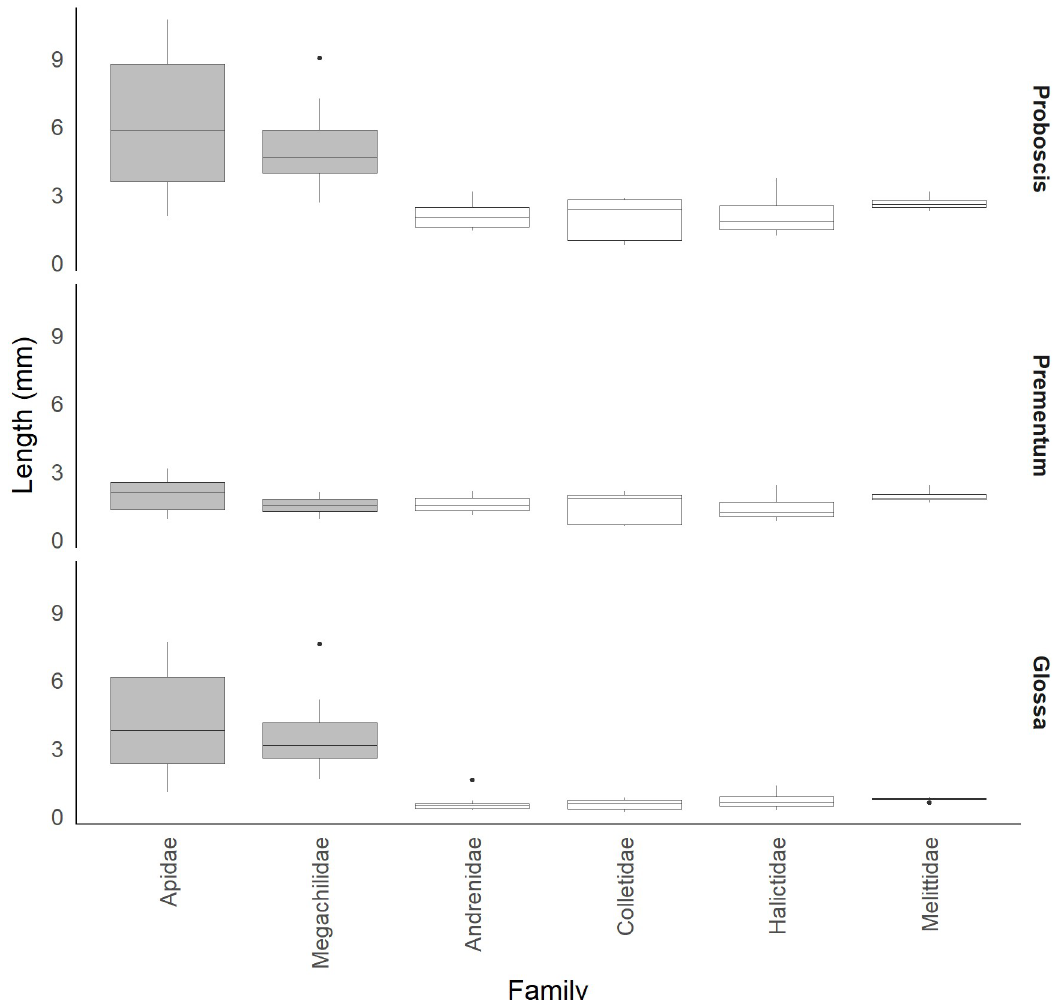
Fig 3. Length of bee mouthparts (proboscis, glossa and prementum). Boxplots of proboscis, glossa and prementum length for six bee families. Long-tongued families are depicted by grey boxplots whereas short-tongued families are depicted as white boxplots. Outliers are shown as dots. Figures are drawn using raw data for Melittidae and data from (Cariveau et al. [12], S2 Table) for Apidae, Megachilidae, Andrenidae, Collectidae and